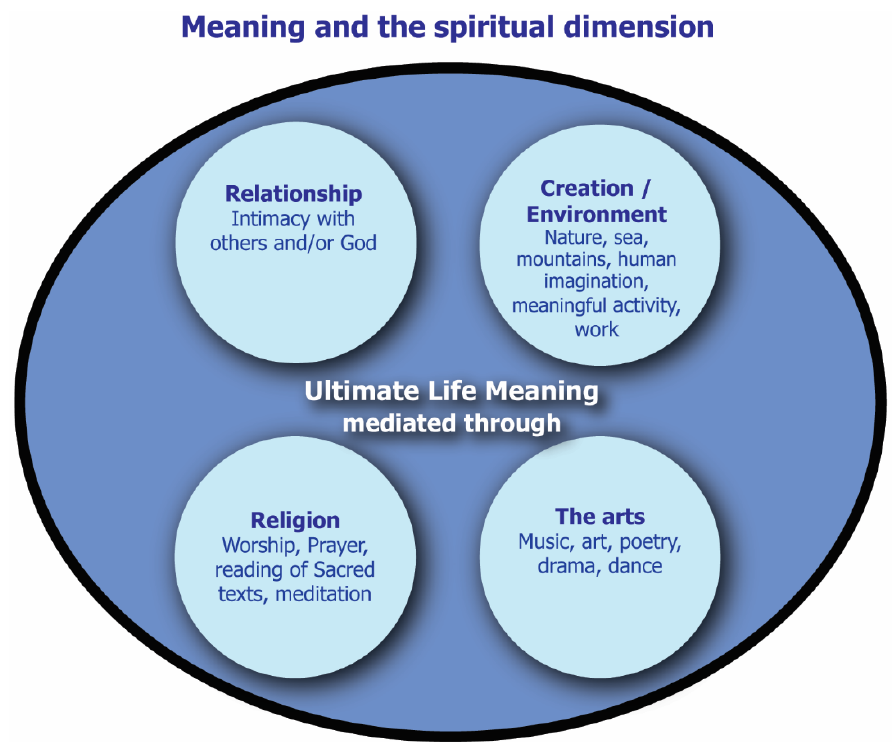
Figure 1. Meaning and the spiritual dimension (MacKinlay 2017).